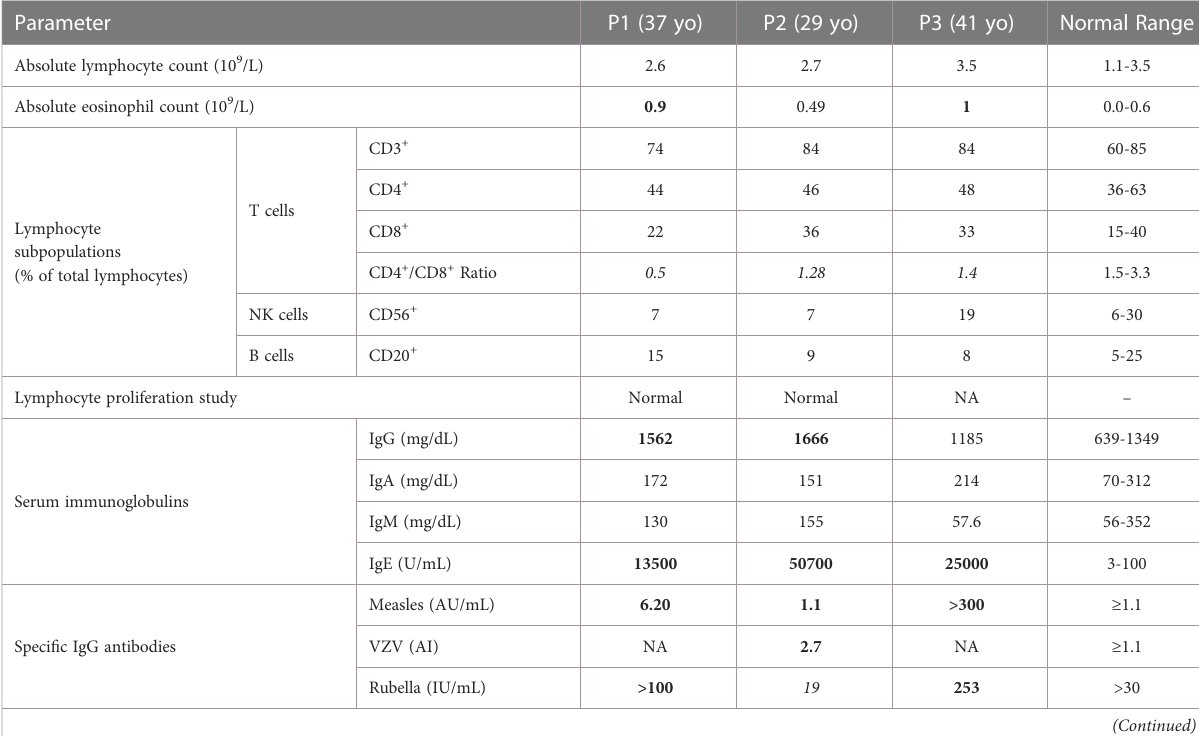
TABLE 2 Immune workup of adult patients with DN- STAT3 variants. Parameter Normal Range Absolute lymphocyte count (10 9